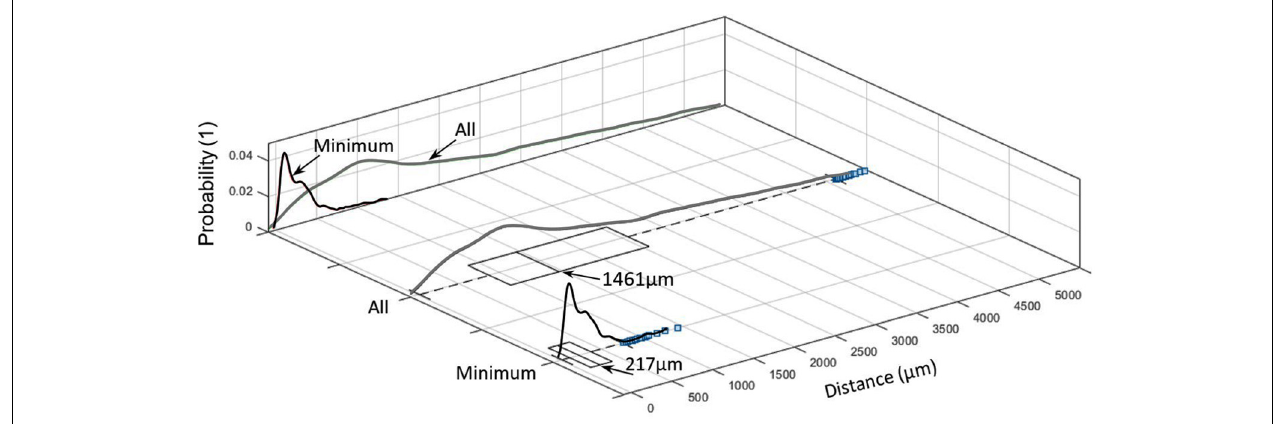
FIGURE 6 | Inter-centroid distance and minimum distance between nerves and arteries within each slide (blue squares denote outliers).